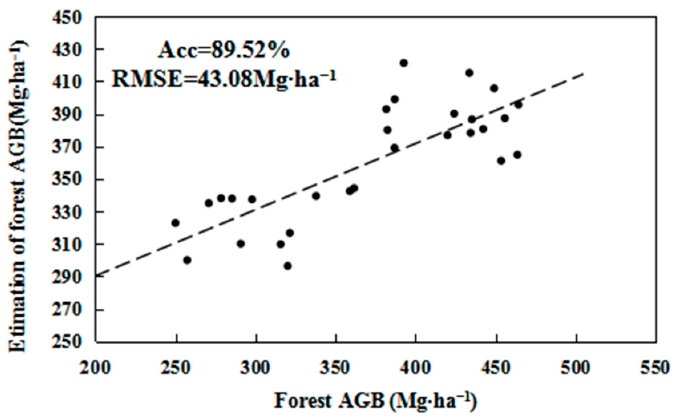
Figure 16. Scatter plot of ground observed with estimated forest AGB by the model taking the BPV-5 and BPV-30 as features.